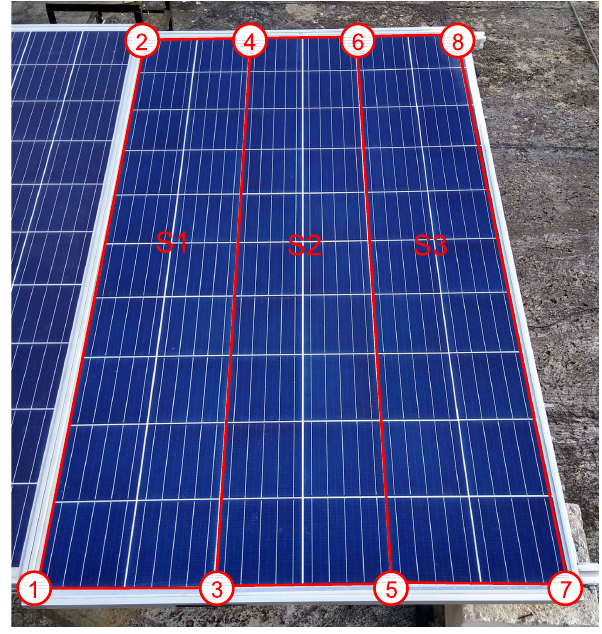
Figure 6. Number of key points considered in the module.